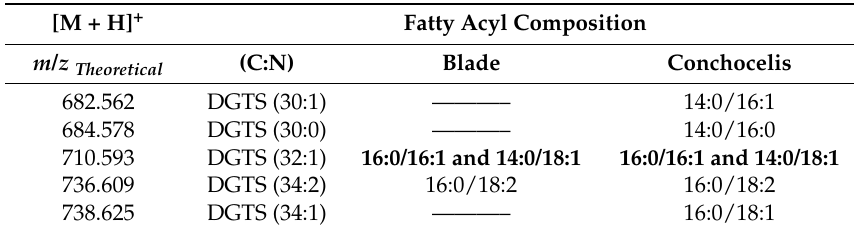
Table 4. Identification of betaine lipids in the lipidome of blade and conchocelis stages of Porphyra dioica by HILIC–LC–MS, mass accuracy and MS/MS. Diacyglyceryl- N , N , N -trimethyl homoserine (DGTS) molecular species were identified as [M + H] + ions.